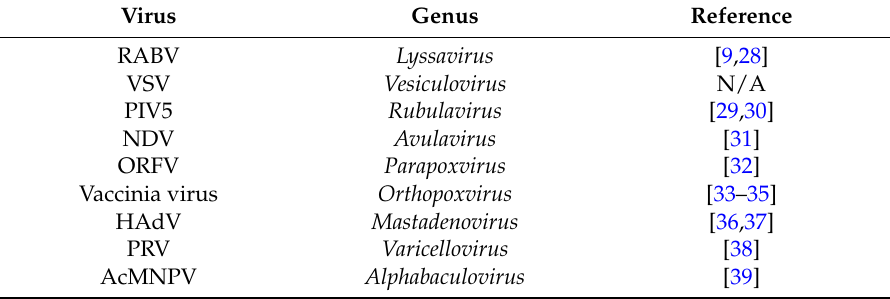
Table 1. A list of viruses that have been engineered to express rabies virus (RABV) glycoprotein (G) protein to act as vaccine candidates for protecting against lethal